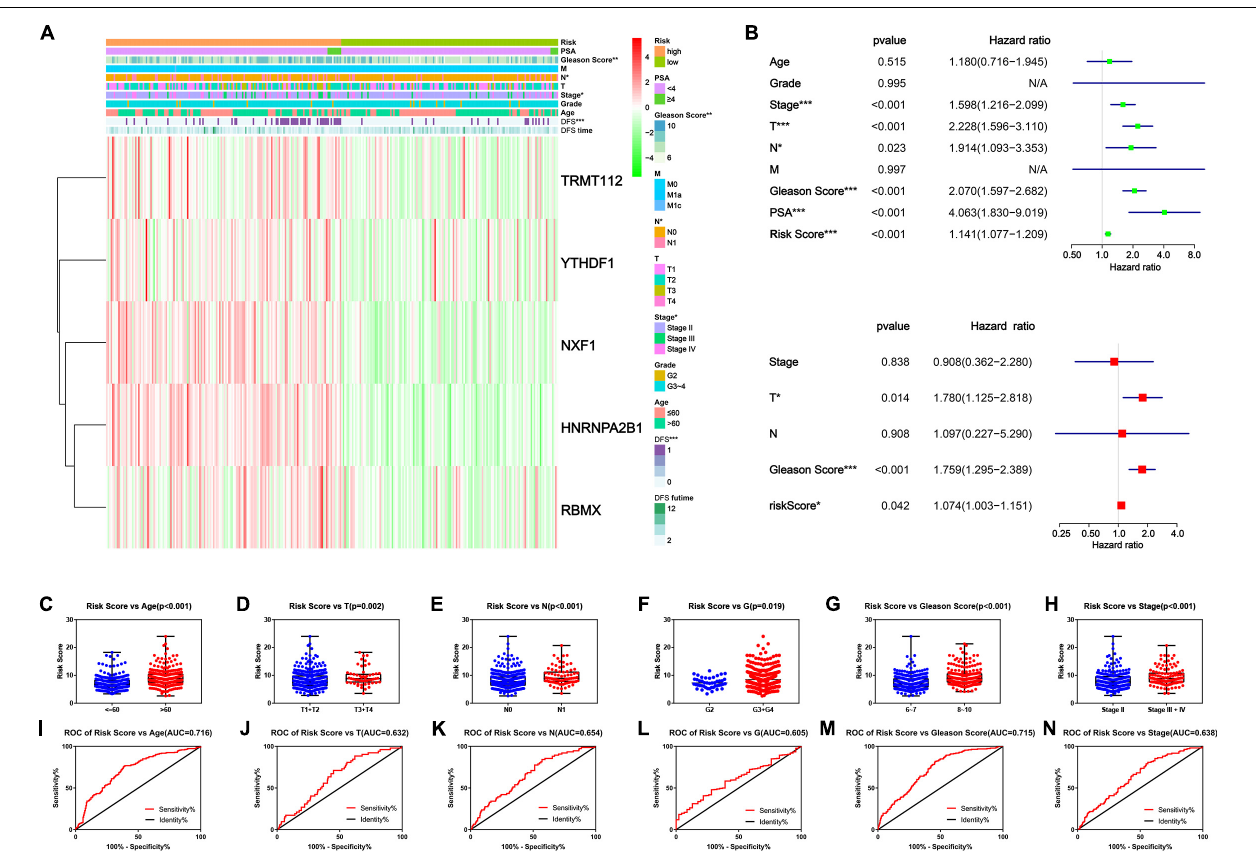
FIGURE 7 | Clinicopathological characteristics of novel risk signature constituted of five m 6 A regulatory genes. (A) The heatmap of five constituent genes of risk signature along with clinicopathological characteristics. (B,C) Univariate and multivariate Cox regression analyses of risk score along with clinicopathological characteristics. (C–H) The distribution of risk score in different clinicopathological characteristics. (I–N) Receiver operating characteristic (ROC) curve for patients with different clinicopathological characteristics.